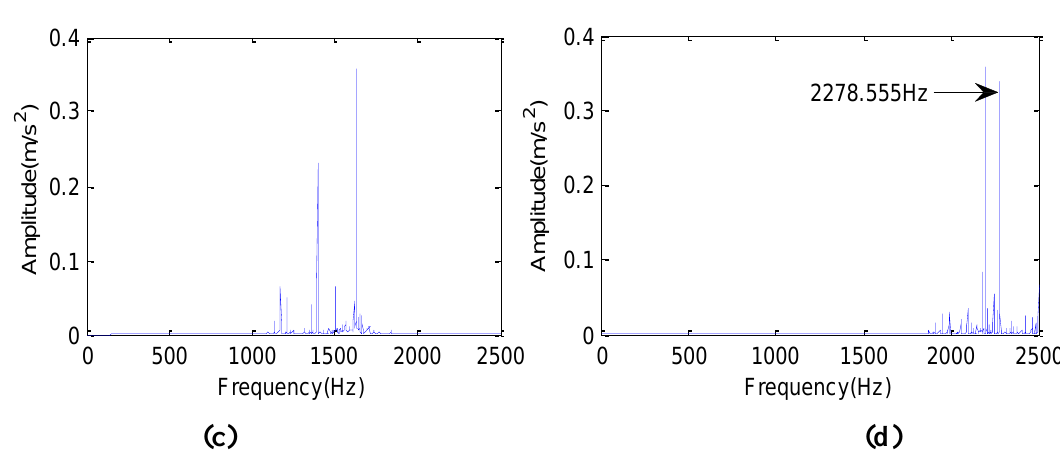
Figure 10. Low frequency spectrum (0~1,250 Hz) of wavelet lifting level 1 decomposition (with the spectrum of c 0 ranging from 0~1,250 Hz).